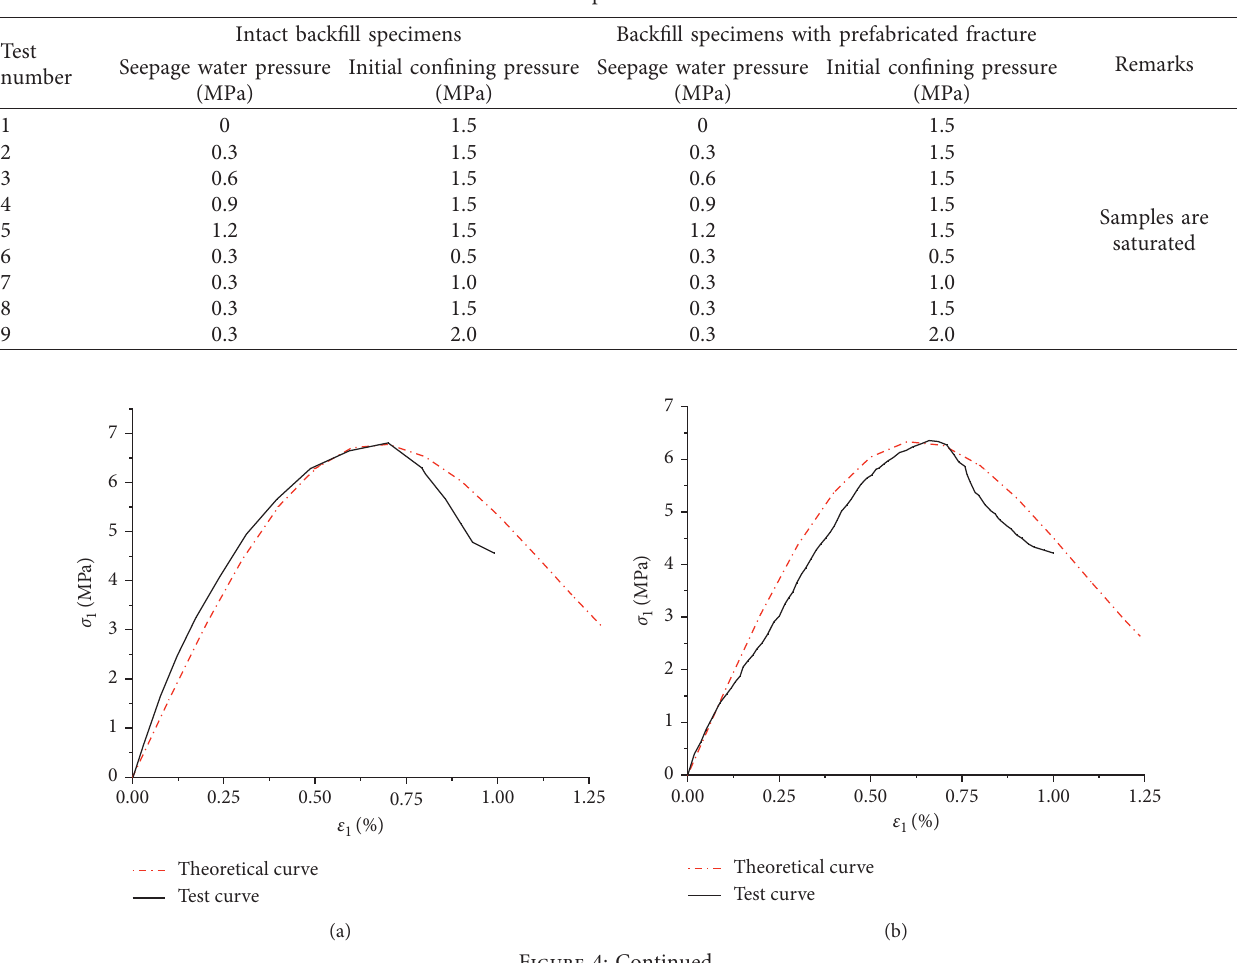
Figure 3: Loading diagram of backfill specimen. Table 3: Experiment scheme.